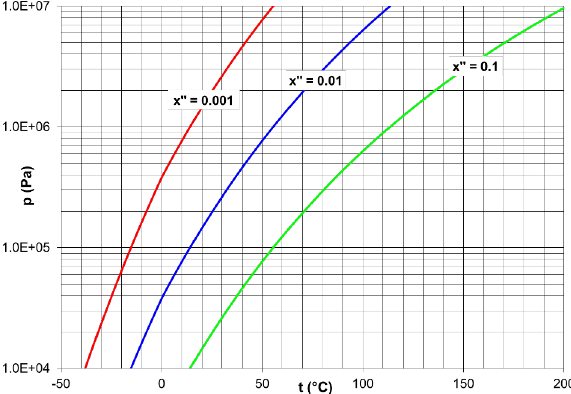
Fig. 2. Saturation lines in p − t diagram for the moist air and di ff erent values of specific humidity x [1] .